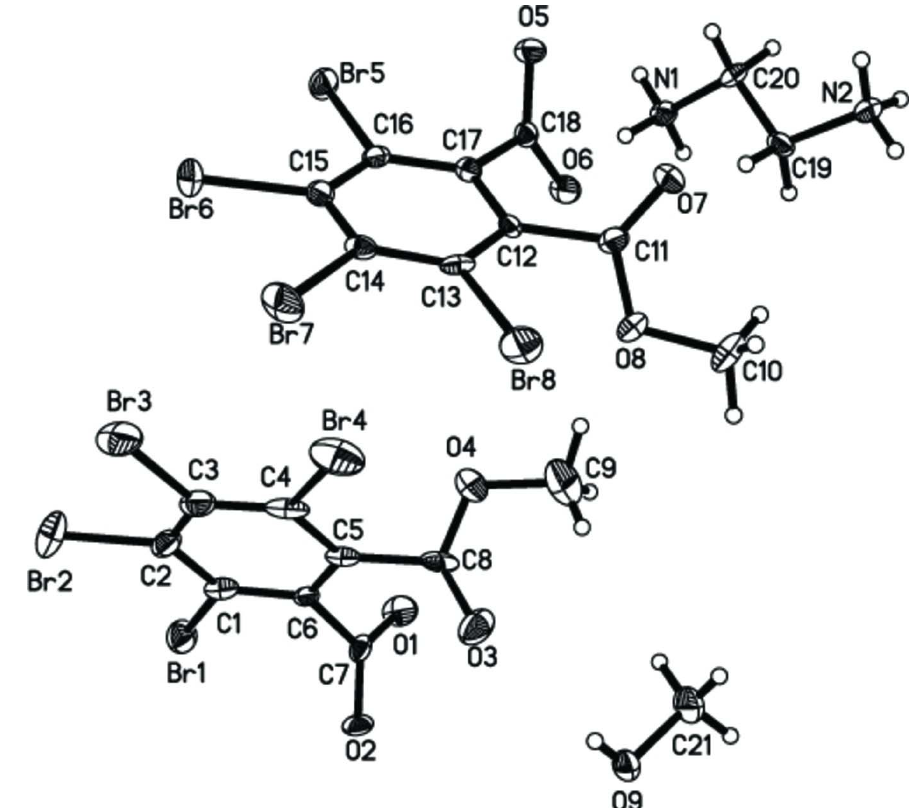
Figure 1 The molecular structure of (I), drawn with 30% probability